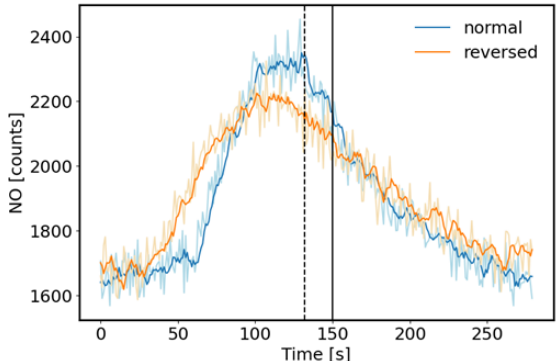
Figure 7. Test of sample air residence time in the flow reactor. A small volume of a 1ppm NO standard was injected through a port upstream of the reactor, and NO was monitored downstream with a fast-response chemiluminescence analyzer (1s time resolution). 5s running averages are presented here. The normal configuration was with the flow entering each flask through the dip tube. The re- versed configuration was with the airflow exiting each flask through the dip tube. The vertical black line indicates the theoretical resi- dence time (150s) based on the total flow rate (4Lmin − 1 ) and total volume (10L) of the reactor, assuming that there was no mixing in- side the flasks. The dotted line depicts the mean of the distribution at 132s for the normal